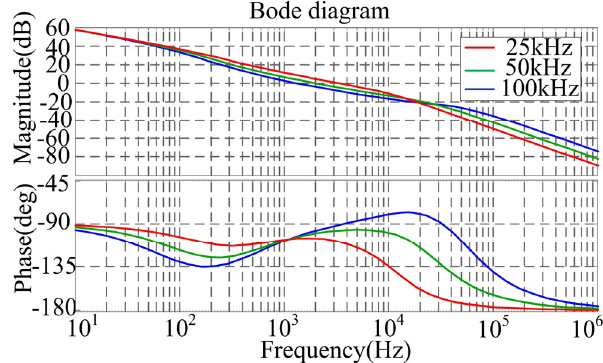
Figure 23. Frequency response of T ( s ) under different frequencies with the adaptive